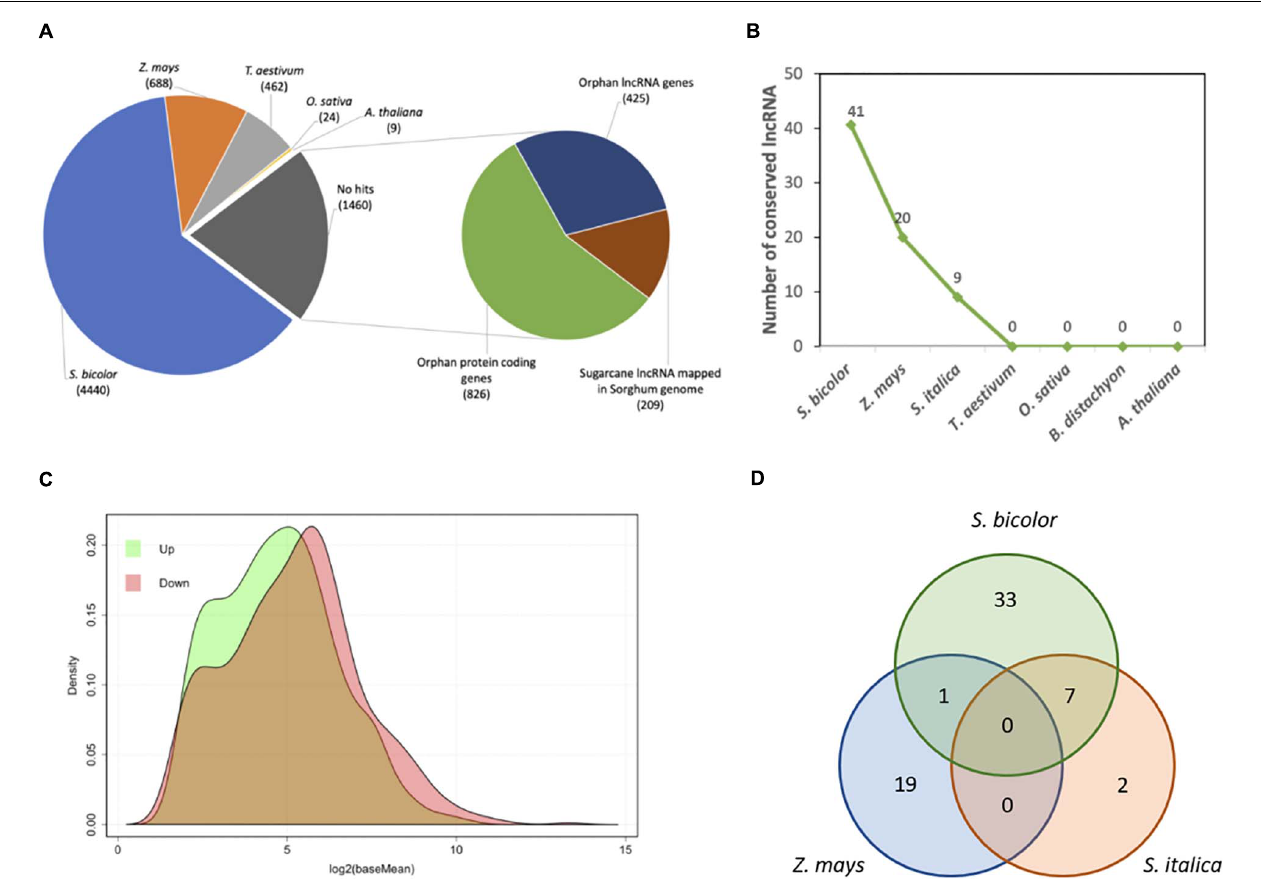
FIGURE 7 | The conservation and expression profile of sugarcane lncRNAs responsive in flowering inducted by photoperiod. (A ) DE sugarcane transcripts (7,083) classified by annotation pipeline: the 1,460 no-hit transcripts were classified into coding (826), conserved non-coding (209), and orphan non-coding (425) transcripts. (B) Number of conserved sugarcane lncRNAs (634) with S. bicolor , Z. mays , S. italica , T. aestivum , O. sativa , B. distachyon , and A. thaliana . (C) Density distribution of up- (840) and downregulated (620) sugarcane no-hit transcripts. (D) Venn diagram with the number of sugarcane lncRNAs showing conservation to related grasses, including shared conservation between